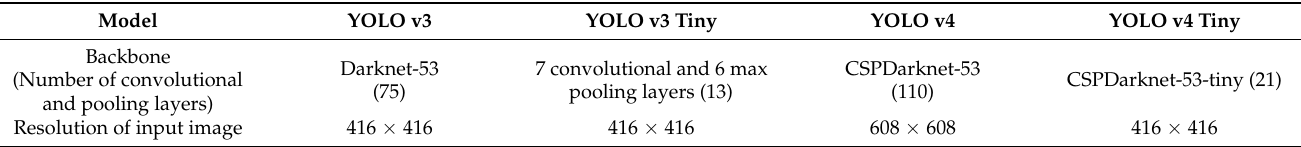
Table 1. The comparison of the models used for algal detection in this study.